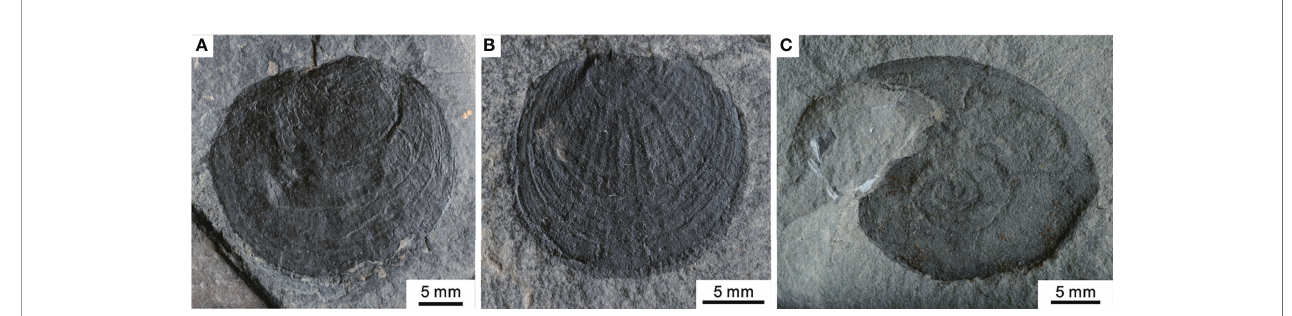
FIGURE 3 | The Early Triassic marker, bivalves and ammonoids of the Chibi section. (A) Claraia wangi from Bed 17. (B) Claraia stachei from Bed 21. (C) Hypophiceras sp. from Bed 18.